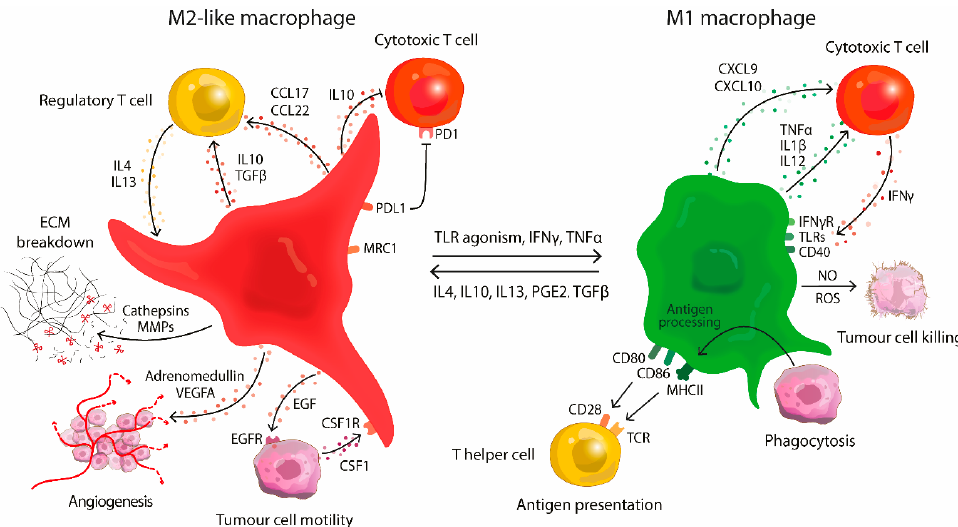
Figure 1. Schematic representation of the functions of M1 and M2-like macrophages in tumour development. During early stages of tumourigenesis activated (M1) macrophages present antigens and support cytotoxic T lymphocytes (CTL) by the production of proinflammatory cytokines. They eliminate tumour cells with nitrogen and oxygen radicals or by phagocytosis. These antitumour macrophages can be seized by the tumour and shifted to an M2-like state by secretion of immunosuppressive cytokines. The formed M2-like macrophages suppress CTL function and redirect them to immunosuppressive T cell subsets. M2 polarised TAMs support tumour growth in all stages of disease including proliferation, angiogenesis and